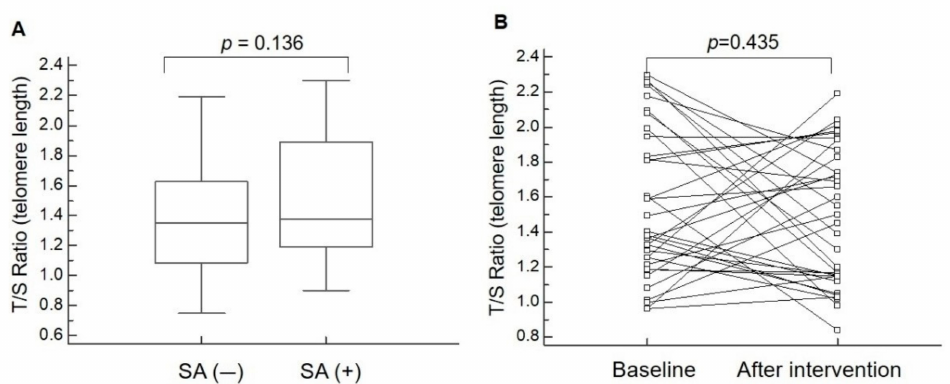
Figure 1. There is no significant di ff erence in telomere length between controls and sarcopenic participants. ( A ) Comparison of the T / S ratio (telomere / single copy gene) for telomere length between research participants with and without sarcopenia (SA). ( B ) Comparison of the T / S ratio for sarcopenic participants at baseline and after exercise and nutrition intervention. Table 2. T / S ratio for telomere length and TERRA expression of the study participants before and after exercise and nutrition intervention. Before Intervention After Intervention p Value ( N = 36) ( N = 36)